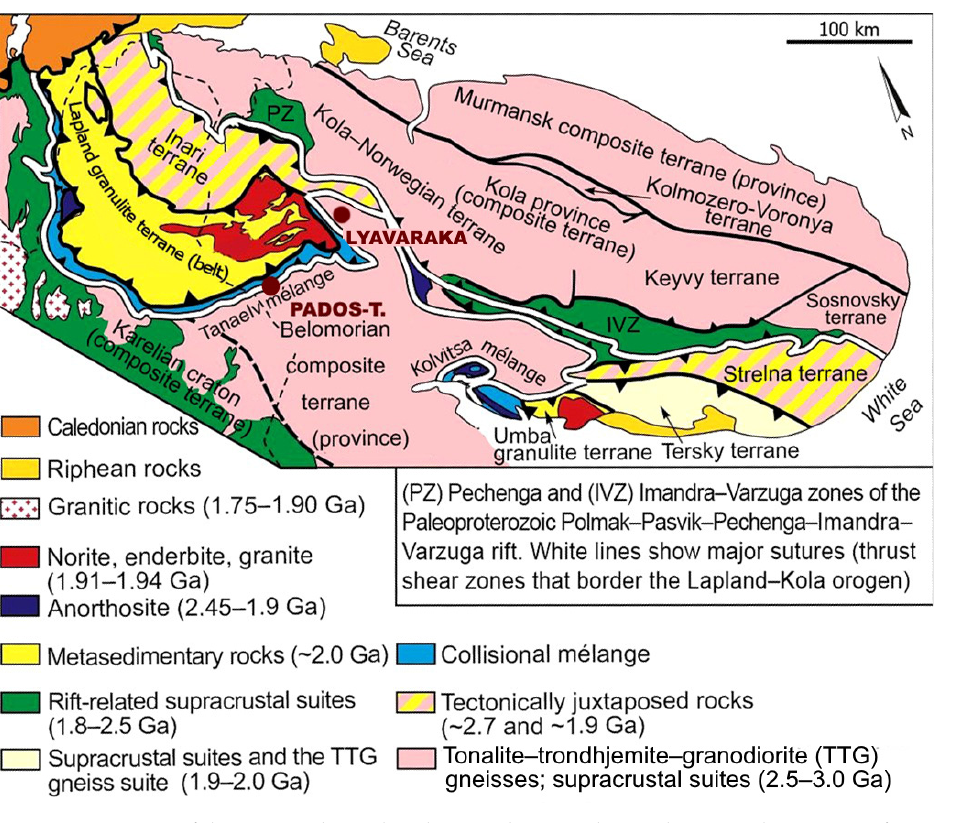
Figure 3. Location of the Lyavaraka and Pados-Tundra complexes, shown in the context of tectonic elements of the northeastern part of the Fennoscandian Shield, after [28] and references therein.